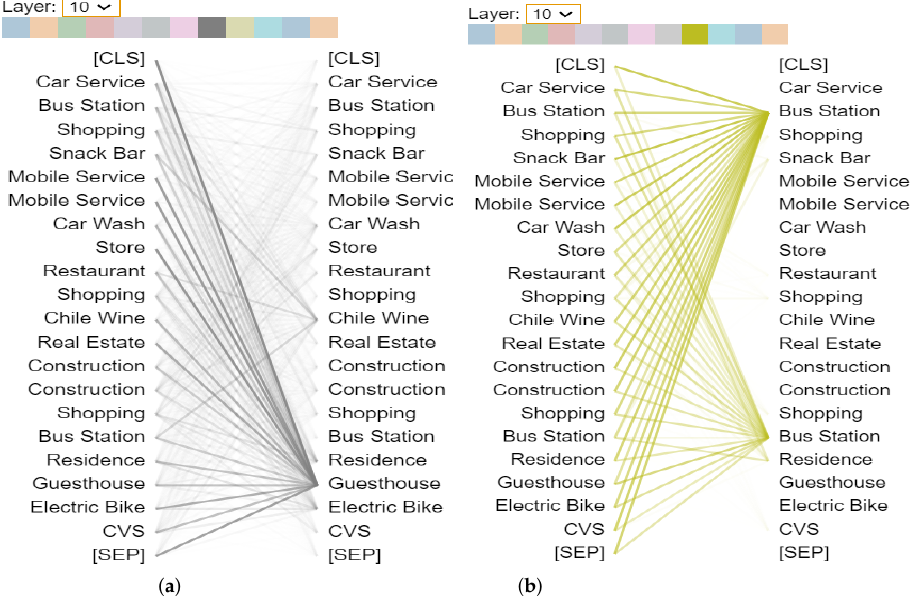
Figure 20. Attention mechanism for addition Case 1 in GeoBERT-ShortestPath. “CVS” is the abbrevi- ation for convenience store. In ( a ), “Guesthouse” obtains attention weights from all other tokens. In ( b ), there are two “Bus Stations” in a grid, and both attract the most attention. Moreover, the weights for the first “Bus Station” are higher. This difference validates that the sequence order plays a role to some extent: ( a ) Layer 10, Head 7; ( b ) Layer 10, Head